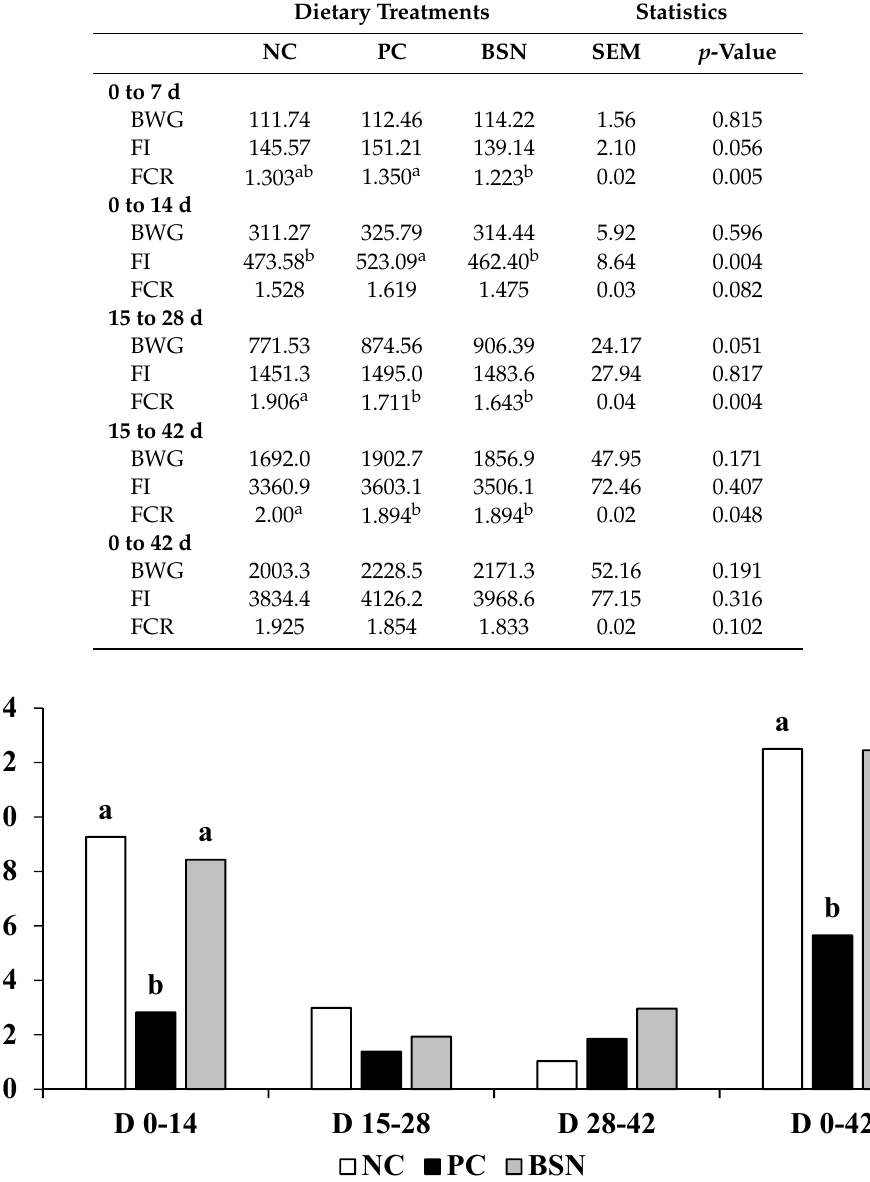
Figure 1. E ff ects of dietary non-drug feed additive (BSN) on mortality rate (%) of the birds during starter, grower, finisher, and overall experimental periods. Bars with di ff erent letters (a–b) di ff er significantly.